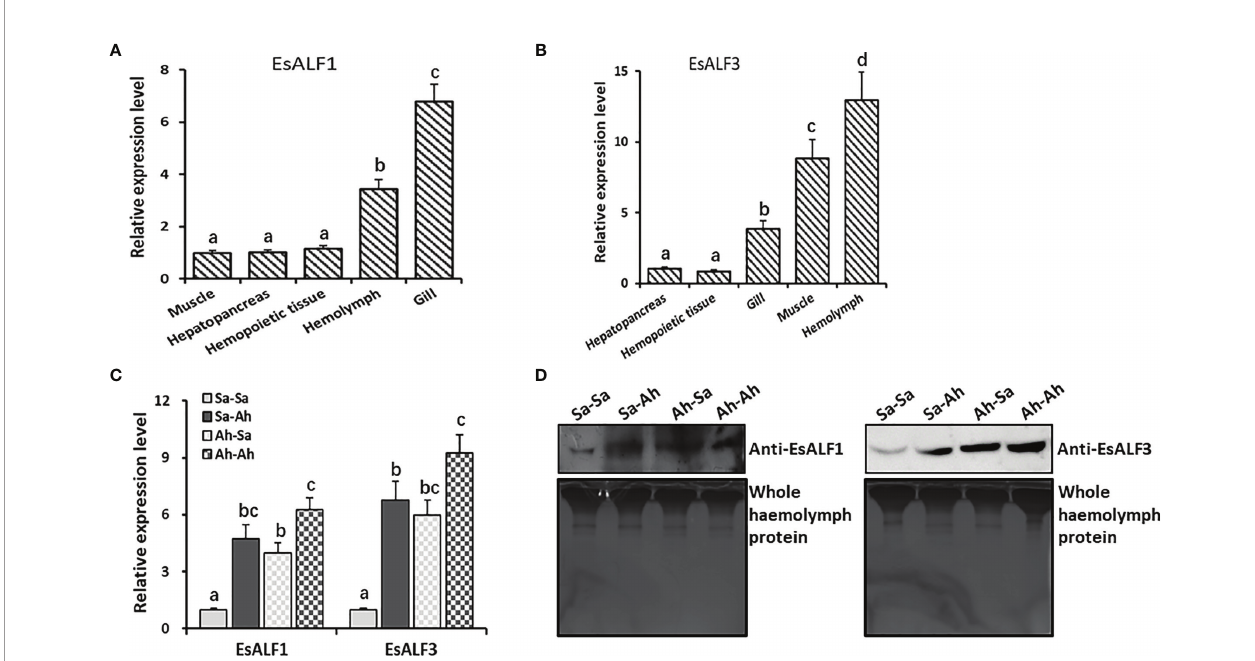
FIGURE 5 | High expression of ALFs in haemocytes and signi fi cant induction after priming stimulation. (A) The expression pattern of Es ALF-1 in different tissues of crab E. sinensis ; (B) The expression pattern of Es ALF-3 in different tissues of crab E. sinensis ; (C) The mRNA expression levels of Es ALF-1 and Es ALF-3 in haemocytes after stimulation of A. hydrophila ; (D) WB analysis of the protein expression levels of Es ALF-1 and Es ALF-3 in cell-free haemolymph after stimulation of A. hydrophila , with whole haemolymph protein used as the internal reference. Vertical bars represent the mean ± S. D. (N = 3), the letters (a, b, c, d) were used to present signi fi cant differences (p <